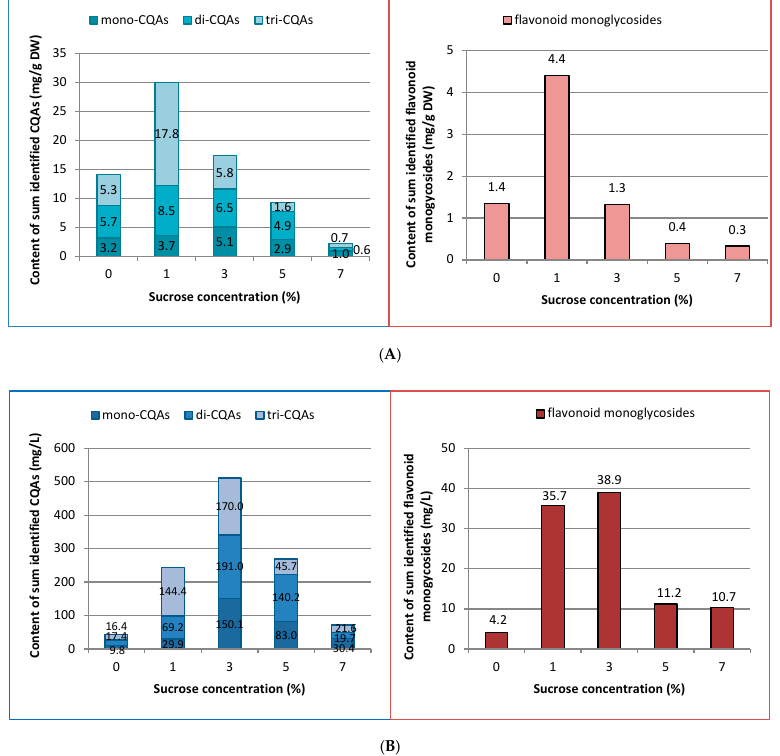
Figure 7. Effect of sucrose concentration (0–7%) on the total content of caffeoylquinic acid derivatives and flavonoid monoglycosides in ( A ) mg g − 1 DW and ( B ) mg L − 1 in R. carthamoides transformed roots cultured in 50 mL of liquid WPM medium in a 300 mL Erlenmeyer flask, in light conditions (16/8-h light/dark photoperiod) on a rotary shaker at 80 rpm.